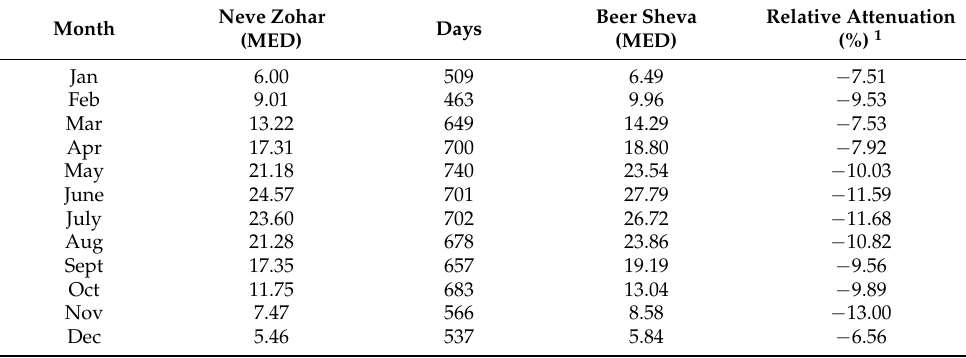
Table 2. Monthly percent daily average relative reduction in UVB irradiation intensities (MED). Neve Zohar Days Month (MED)